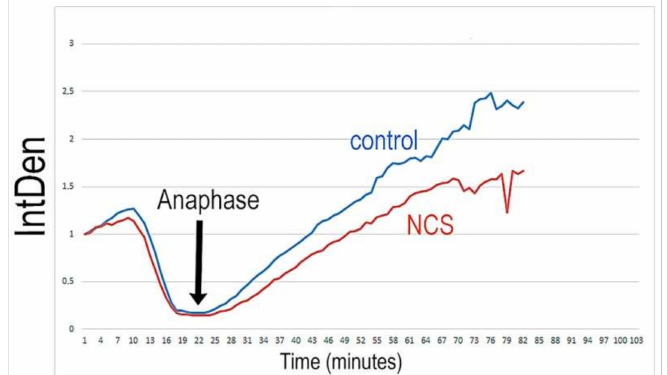
Figure 10. Time course of the changes in the level of securin during the first cleavage in control and NCS-treated embryos.The graph shows relativized values of the measured fluorescent signal densities.